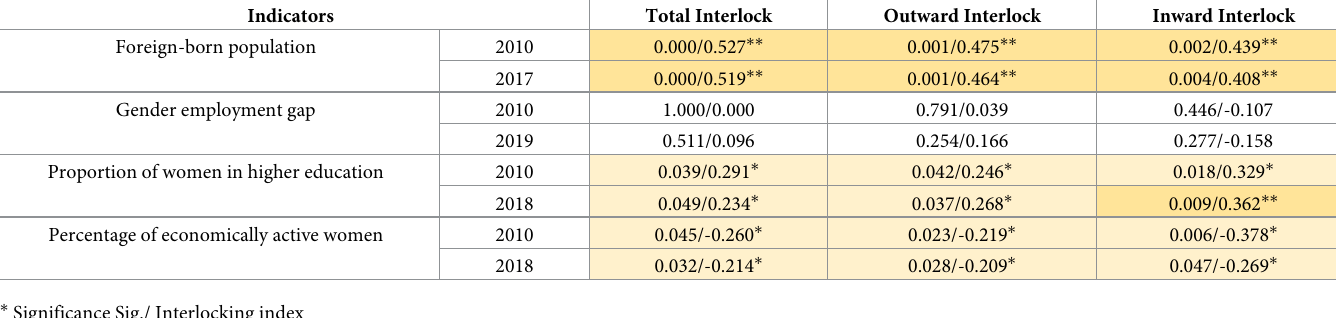
Table 8. The relationship between tolerance indicators and three interlock